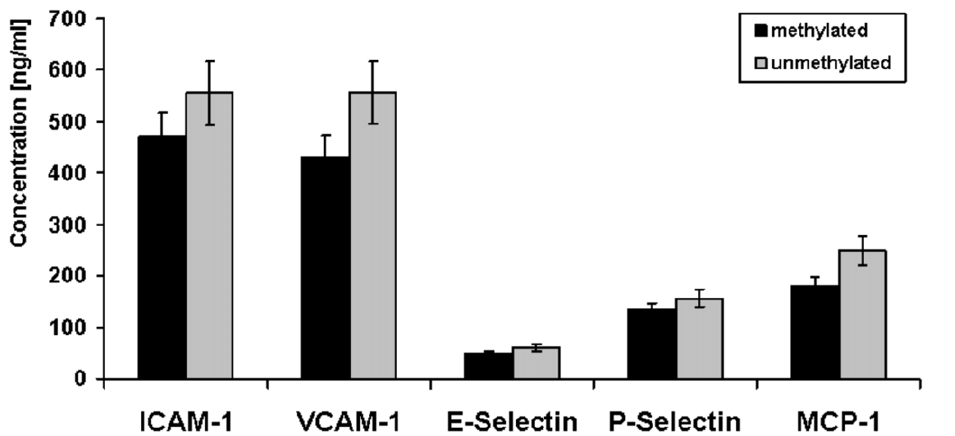
Figure 5. Serum concentrations of inflammatory markers (baseline) among medication-free depressive patients in relation to their methylation status in the ( 2 456/ 2 255) region of the ACE gene. Patients with methylated CpG sites in the ( 2 456/ 2 255) region showed decreased concentrations of all inflammatory markers compared to unmethylated patient samples (not statistically significant).